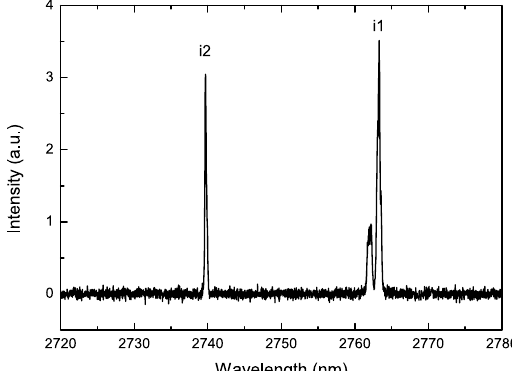
Figure 6. Idlers spectra. Spectra of the idlers waves, i1 and i2 , at a pump energy of 203 µ